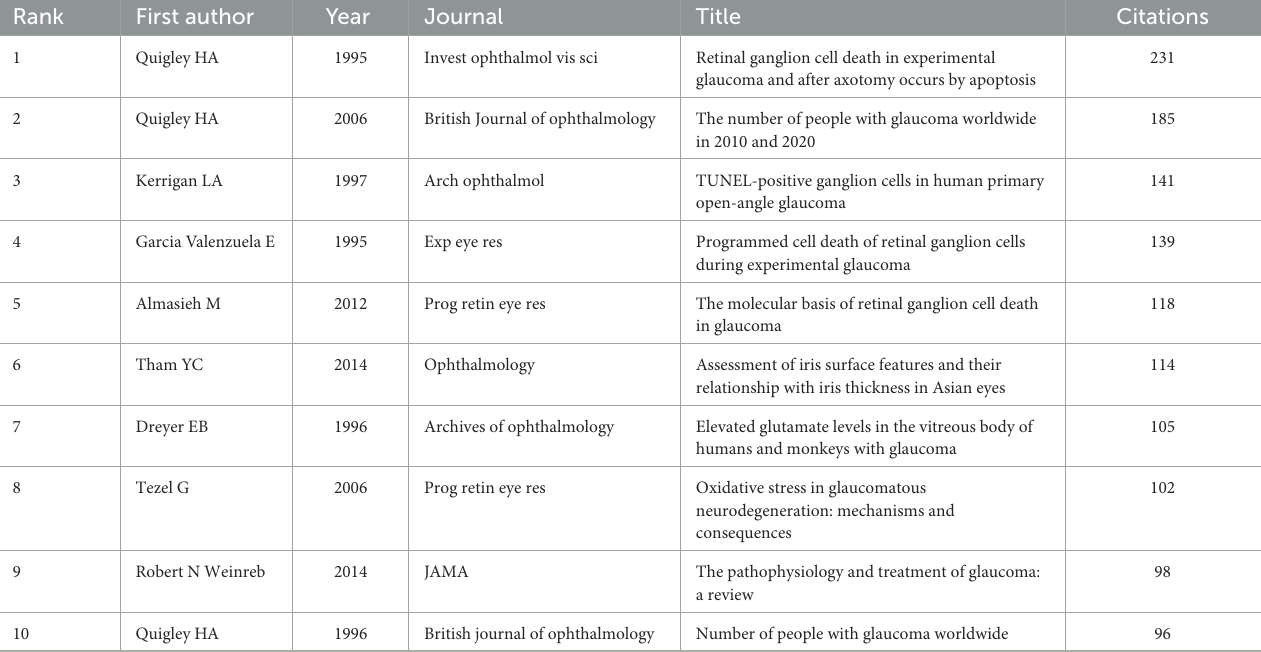
TABLE 6 The top 10 most co-cited